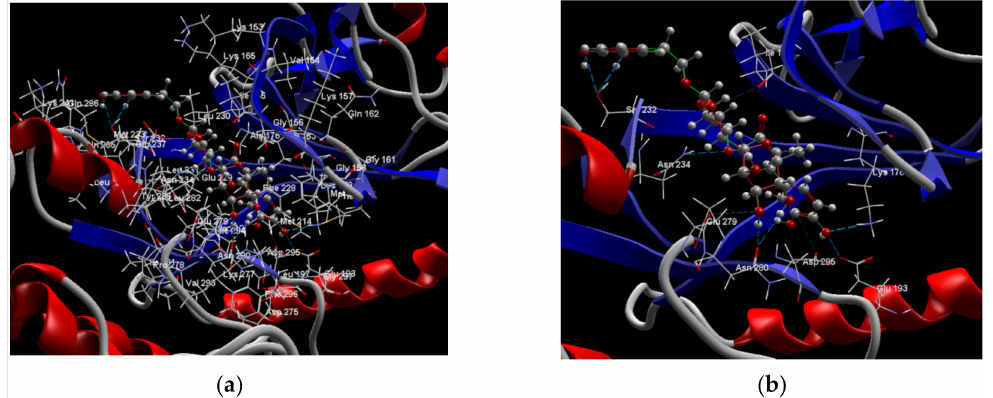
Figure 2. Interactions between verbascoside and the amino acid residues from the active binding site of 5ZTN: ( a ) a general docking image of the verbascoside interacting with the amino acid residues of the binding site, and ( b ) the hydrogen bonds between verbascoside and LYS 178, GLU 193, ASN 234, ASN 280, ASP 295, GLU 279, ILE 155, and SER 232 active amino acids (MVD).